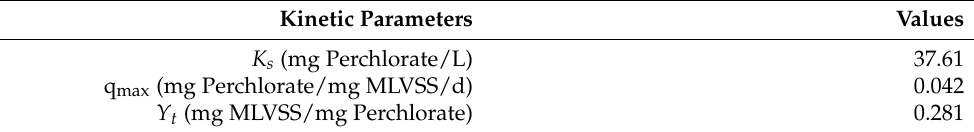
Table 1. Summary of kinetic parameter evaluation by a batch test of perchlorate biodegradation.